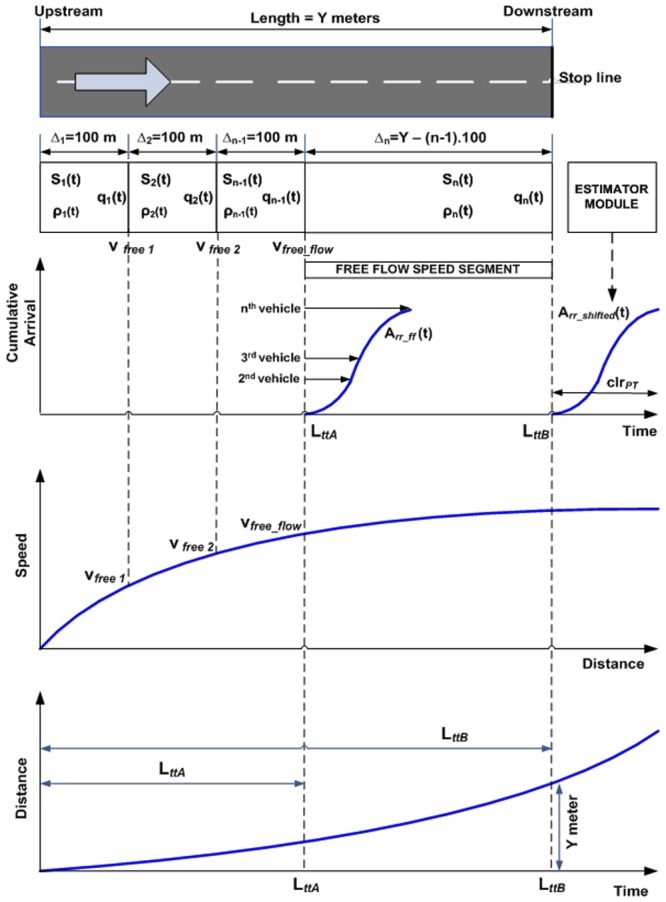
LWR-Integrated Model (LWR-IM).